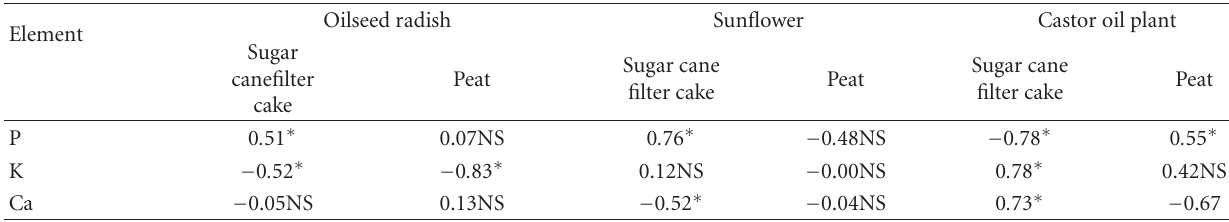
Table 5: Correlation between Ba and P, K and Ca concentrations in shoots.